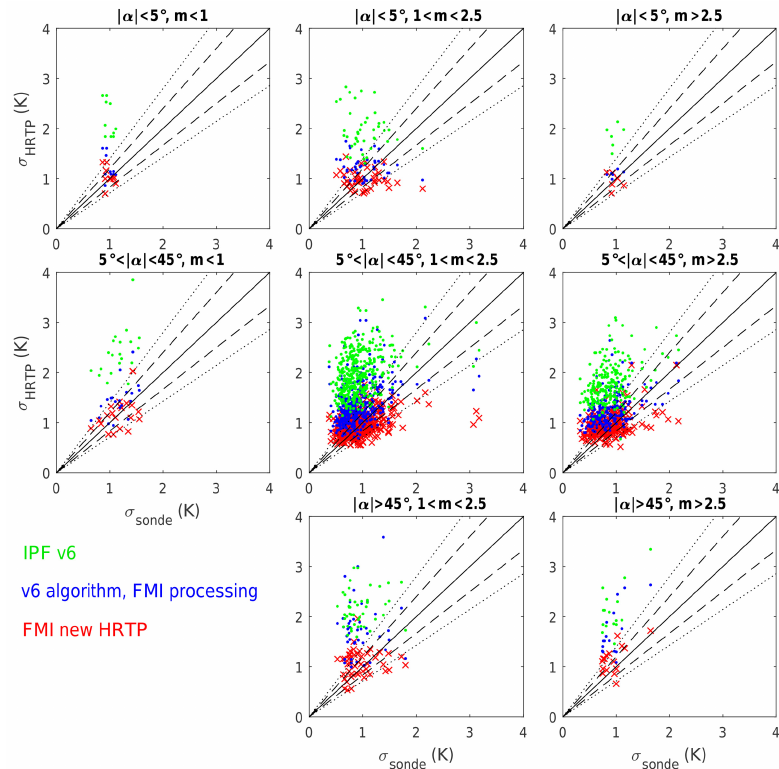
Figure 10. Standard deviations of temperature fluctuations in the altitude range 18–30km for occultations of different types (see text for explanation). Processing version: IPF V6 (green), the V6 algorithm implemented in the FMI scientific processor (blue) and the new HRTP- FMI algorithm (red). Dashed black lines: y = 1 . 2 x and y = ( 1 / 1 . 2 )x ; solid black lines: y = 1 . 4 x and y = ( 1 / 1 . 4 )x .